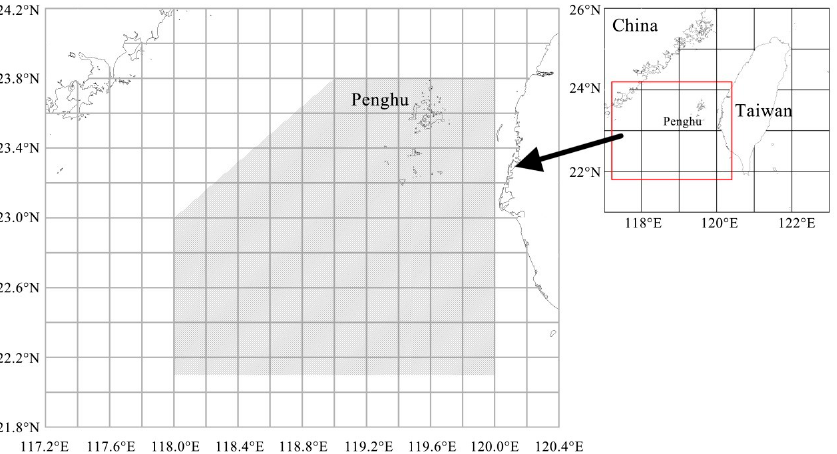
Figure 1. Sampling area of the spot-tail shark in the Taiwan Strait.